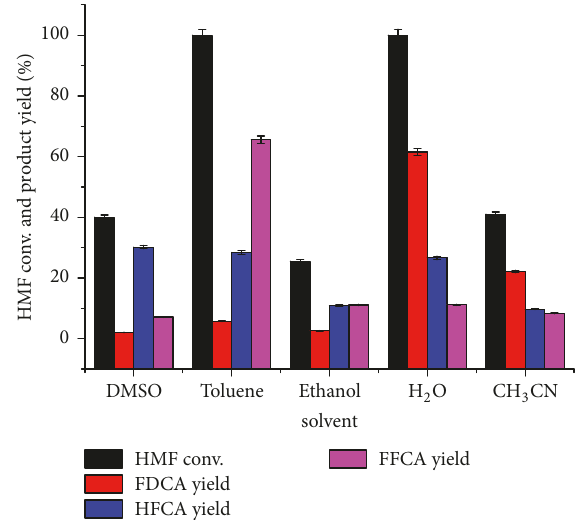
Figure 6: Effect of the solvents on the HMF oxidation. Reaction conditions: Pd/C-OH − (40 mg), HMF (10mg), 353 K, and 12h.